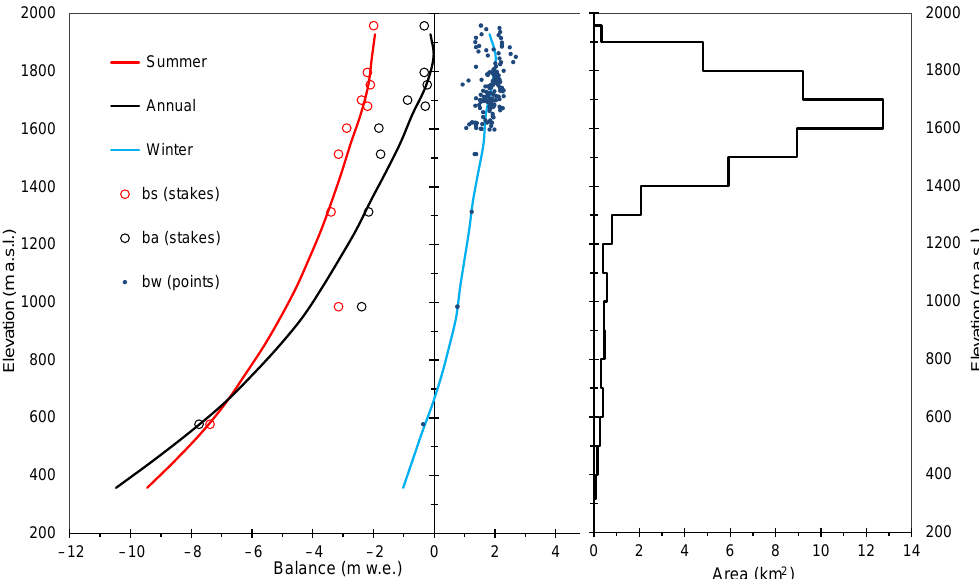
Figure 3. Illustration of the profile method for Nigardsbreen 2003. The altitudinal winter, summer, and annual mass-balance curves and point values for b w (red ◦ ), b s ( ◦ , black), and b a (blue • ), together with average b w (blue (cid:3) ) for each 100m altitude interval are plotted vs.